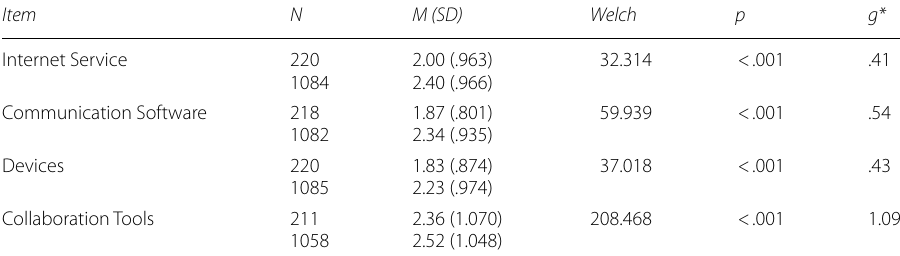
Table 8 Comparison of gains scores between students who preferred online instruction versus those who preferred face-to-face (f2f) instruction for accessibility before and after the shift to remote